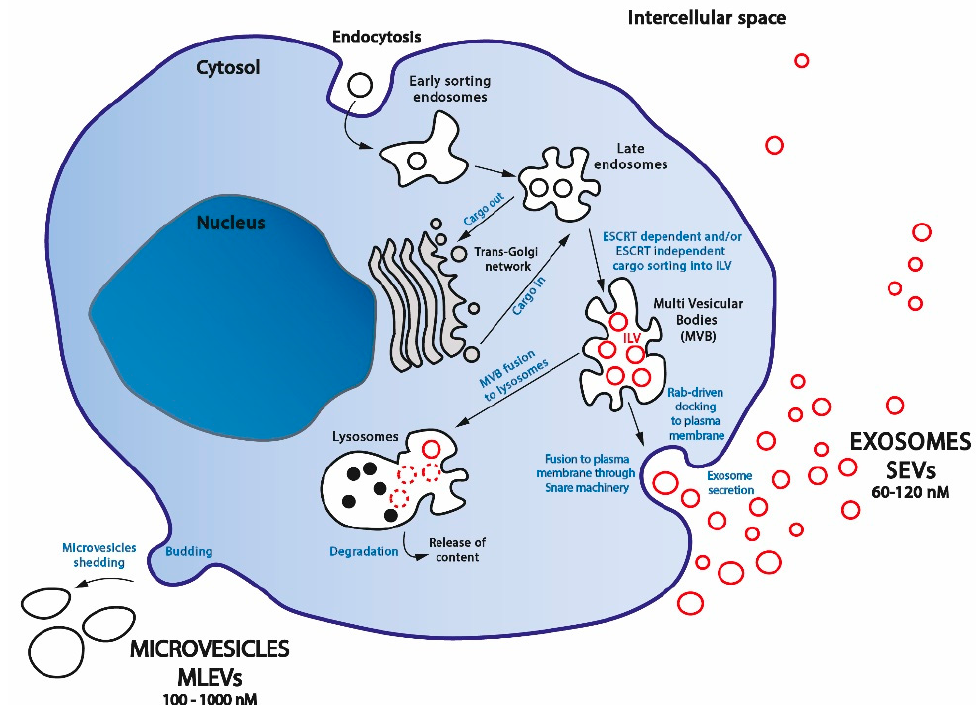
Figure 1. SEVs biogenesis and release. SEVs may have multiple origins. They can originate from plasma membrane budding, which leads to heterogeneous membranous medium-large vesicles (MLEVs) shedding. Small EVs (SEVs, exosomes) originate from the internal budding of plasma mem- branes giving rise to early endosomes. By complex maturating interactions with the Golgi apparatus (cargo-in/cargo-out), early endosomes become late ones. The membranes of late endosomes form intraluminal vesicles (ILVs), small cargos containing proteins from the plasma membrane, and Golgi as well as nucleic acids. Endosomal cargo sorting was performed through either ESCRT-dependent or -independent routes; the ESCRT complex being the key machinery of protein sorting into SEVs. ILVs are contained in multivesicular bodies (MVBs) that fuse with either plasma membrane (after Rab-driven docking), releasing SEVs in the extracellular space (through Snare complex assembly) or with lysosomes for further internal